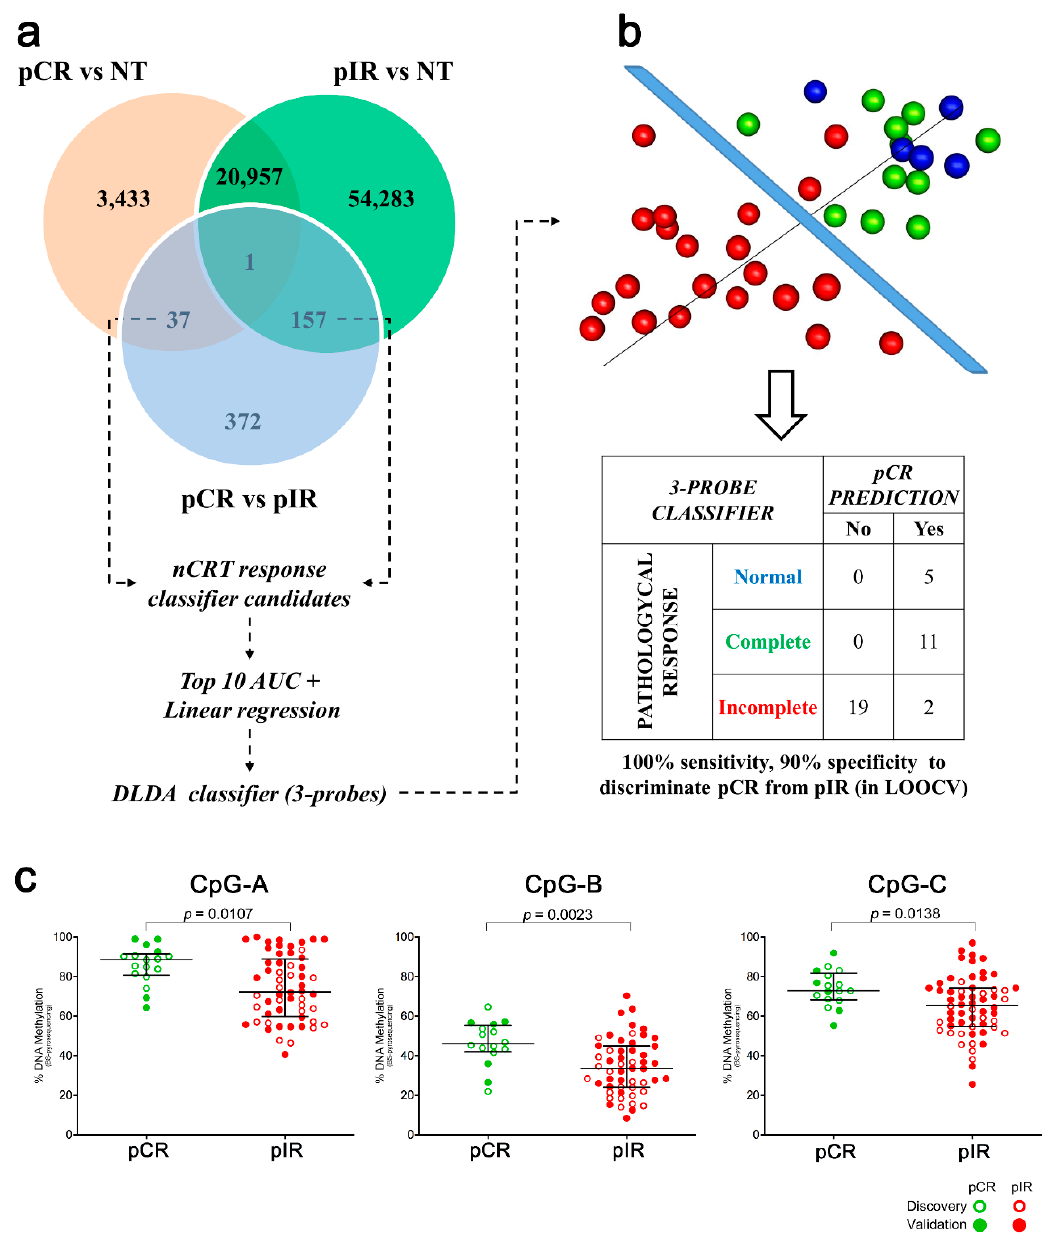
Figure 3. Development and performance of the classifier associated with response to treatment. ( a ) Venn diagram showing the number of differentially methylated probes overlapping among the group comparisons (pCR vs. NT, pIR vs. NT, and pCR vs. pIR) that were used for developing a predictive model based on Diagonal Linear Discriminant Analysis (DLDA). ( b ) Tridimensional distribution of samples according to the methylation values of the three probes included in the classifier and their performance in discriminating patients with pCR or pIR tested using Leave-One-Out Cross- Validation (LOOCV). Normal tissue (NT) samples were also tested using the classifier. ( c ) Methylation status of three CpGs (CpG-A: cg01072658, CpG-B: cg03085846, CpG-C: cg13770628) identified as potential biomarkers of response to neoadjuvant chemoradiotherapy in locally advanced rectal cancer evaluated by bisulfite pyrosequencing. BS-pyroseq: bisulfite pyrosequencing, pCR: pathological complete response, pIR: pathological incomplete